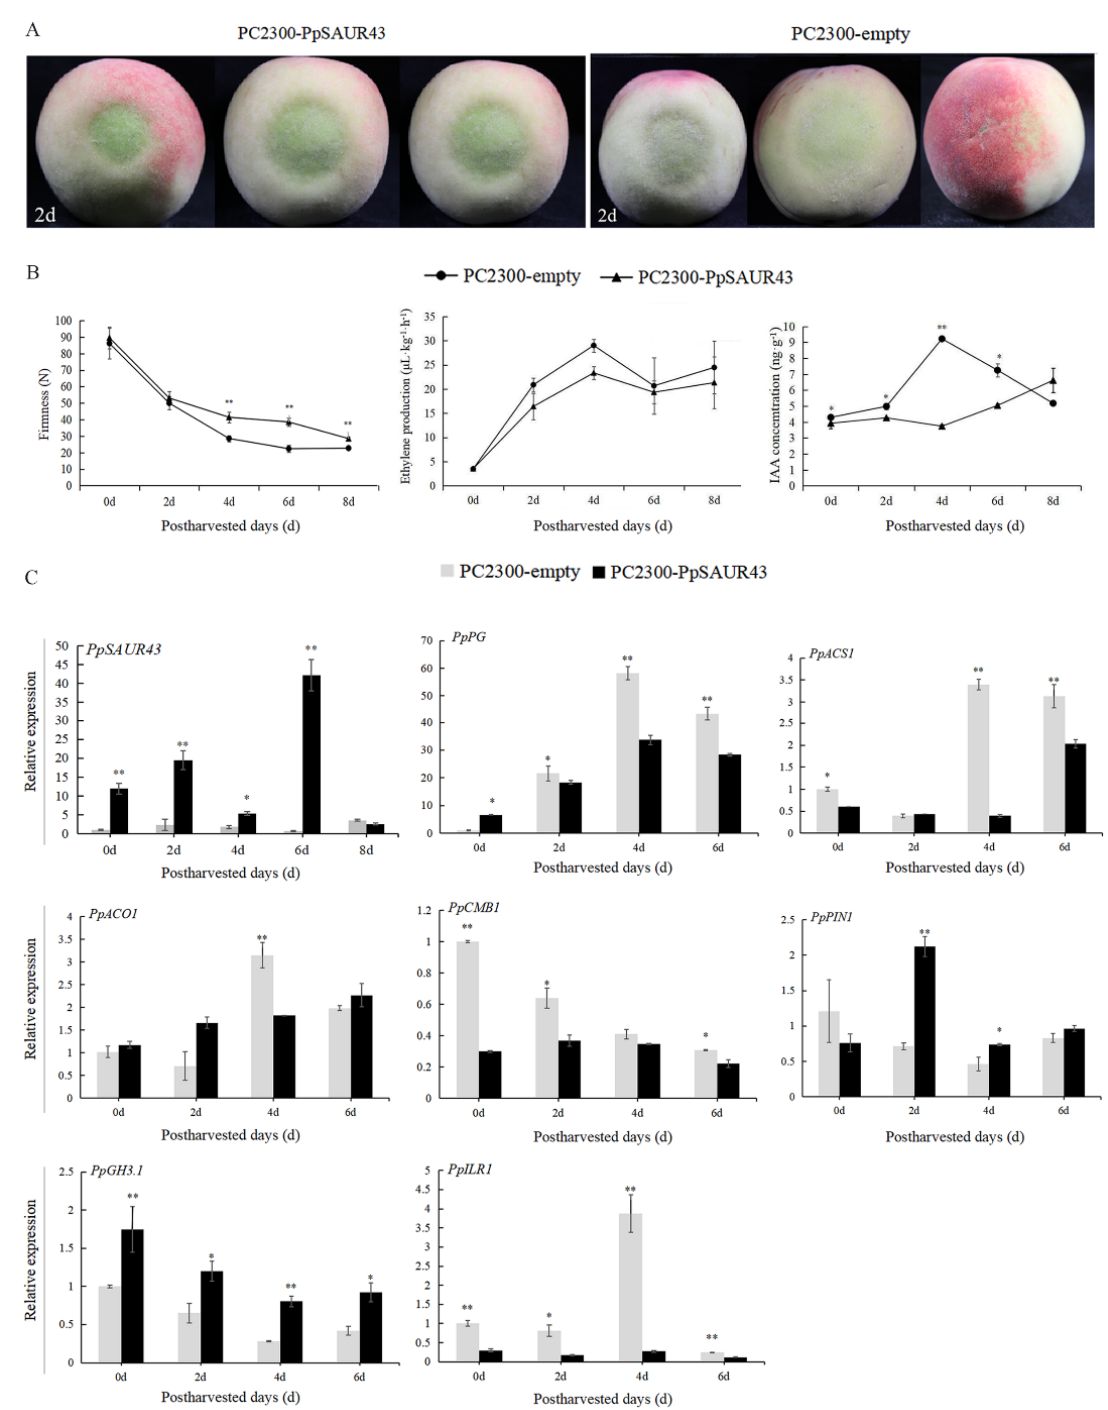
Figure 4. Transient overexpression of PpSAUR43 in ‘YHL’ fruit. ( A ) Phenotypes of infiltrated fruits. Empty pCAMBIA2300 vectors (PC2300 ‐ empty) were used as a control. ( B ) Changes in fruit firmness, ethylene production, and IAA concentration during fruit storage. ( C ) Gene expression of PpSAUR43 , PpPG , PpACS1 , PpACO1 , PpCMB1 , PpPIN1 , PpGH3.1 , and PpILR1 . Gene expression was measured relative to that of PpTUA5 . Fruit was stored at 25.0 ± 1 °C after harvest. At the same storage days, PC2300 ‐ PpSAUR43 was compared with controls. Error bars represent the SD of the measurements from three independent repeat experiments. Duncan’s test was used to compare the differences. * p < 0.05; ** p < 0.01.